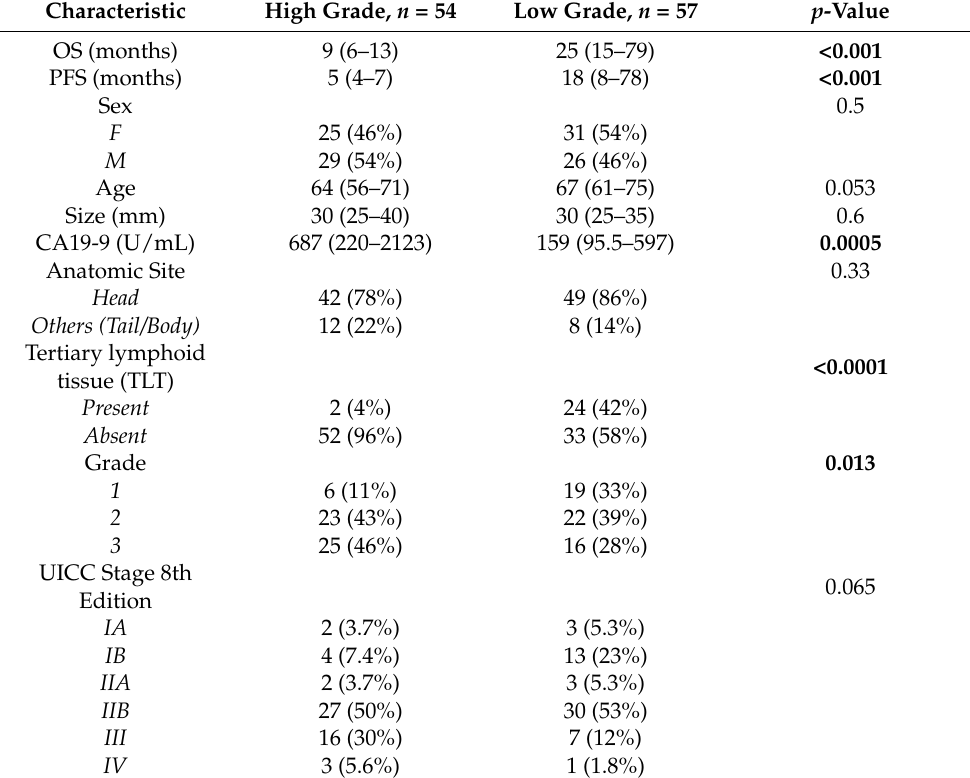
Table 1. Comparison of clinical and pathological parameters between High and Low grade budding patients. Quantitative data are presented as group medians with interquartile range (IQR) in brackets. Categorical data are shown number of cases and as a percentage of survival subgroups in